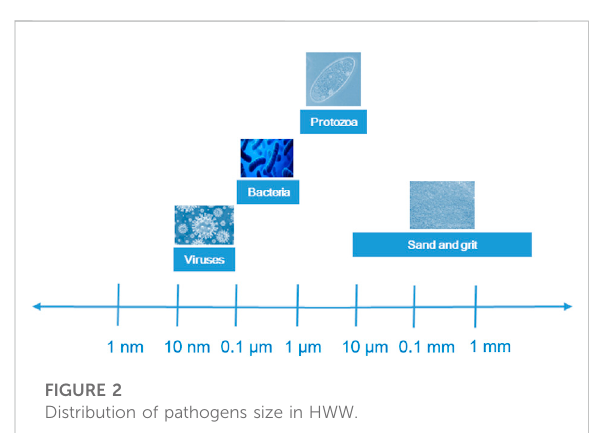
FIGURE 2 Distribution of pathogens size in